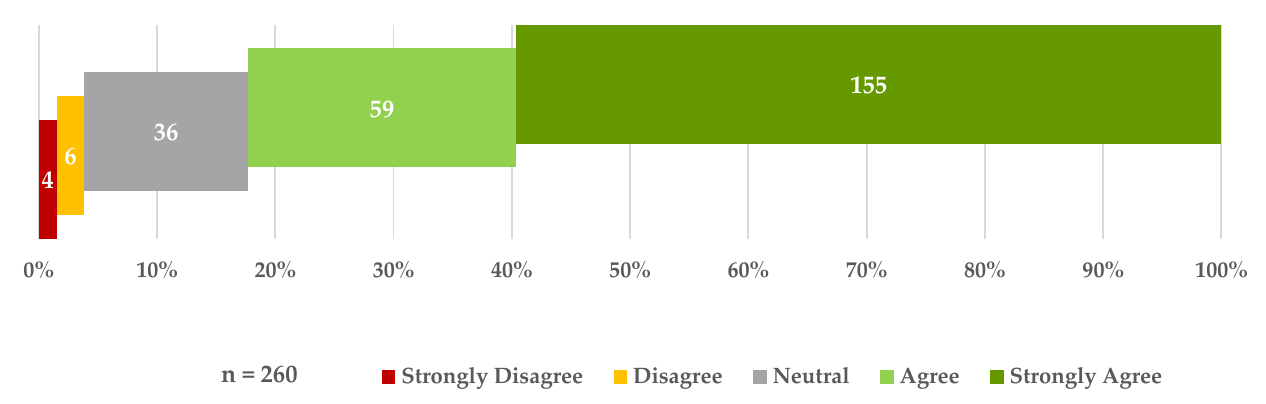
Figure 3. Trust toward COVID-19 vaccines provided in Saudi Arabia.